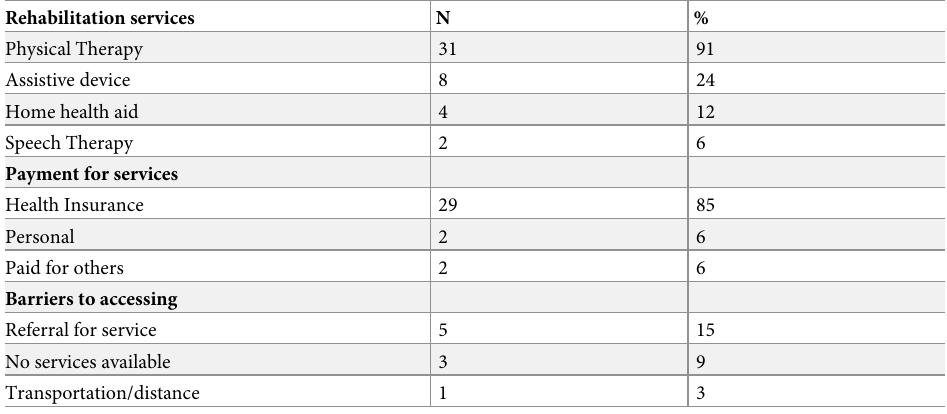
Table 2. Characteristics of rehabilitation services for follow-up GBS cases, Barranquilla, Colombia.